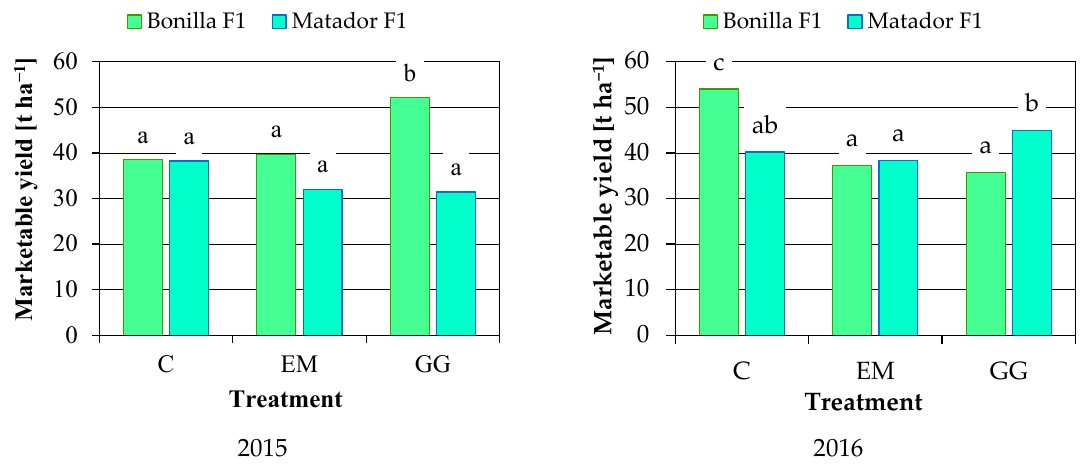
Figure 2. Marketable yield of shallots. Means followed by different letters are significantly different for each parameter. C—control treatment, EM—1% solution of Effective Microorganisms, GG—0.1% solution of Goëmar Goteo.